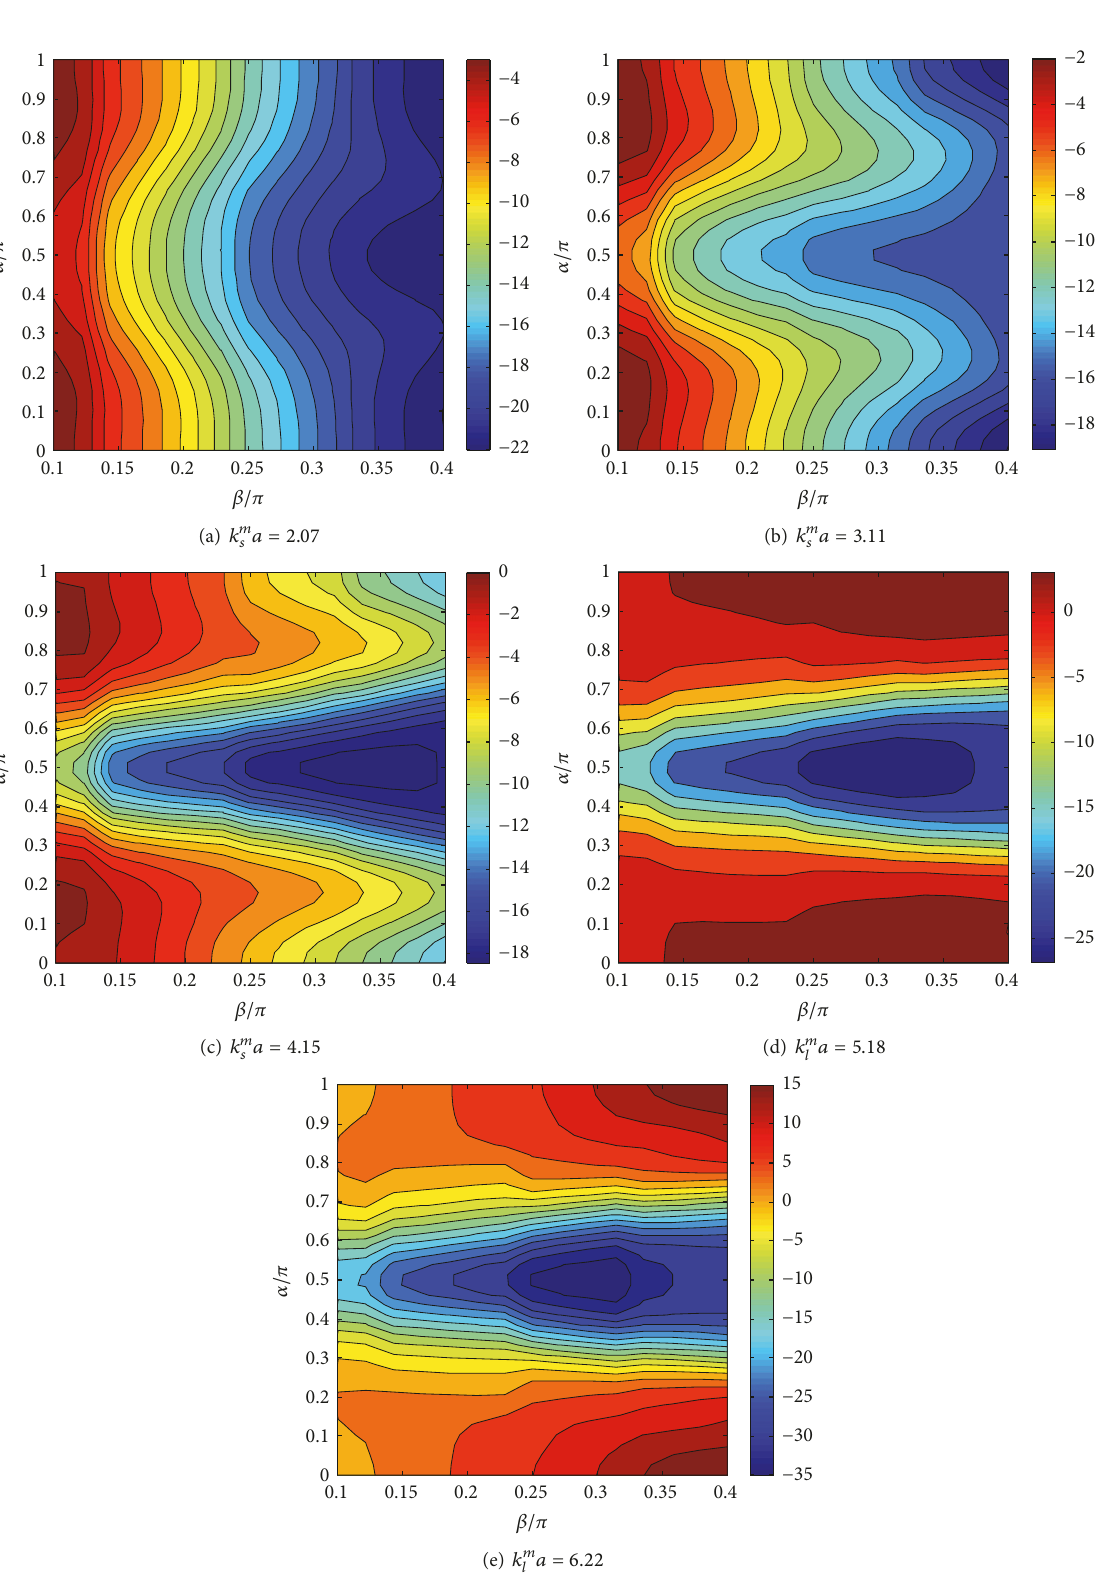
Figure 8: Relative difference (%) of the calculated 𝜎 𝑠 by a fiber with a partially imperfect bonding and with the fully perfect bonding, under the SV-wave incidence at several different normalized